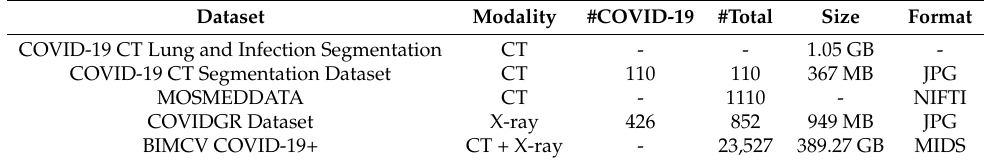
Table 7. Summary of COVID-19 image segmentation